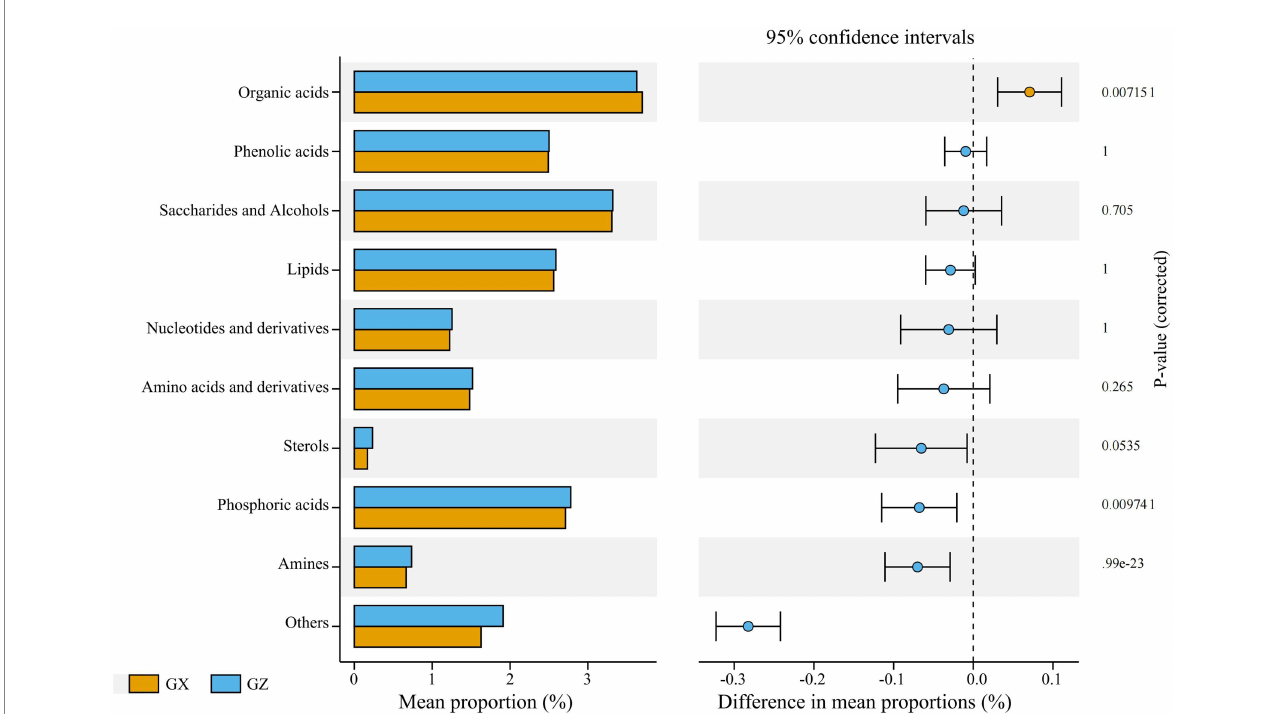
FIGURE 3 Extended error bar plot indicating the Masson pine families from the two provinces. Welch’s t -test at α = 0.05. GX represents the Masson pine families from the Guangxi province; GZ represents the Masson pine families from the Guizhou